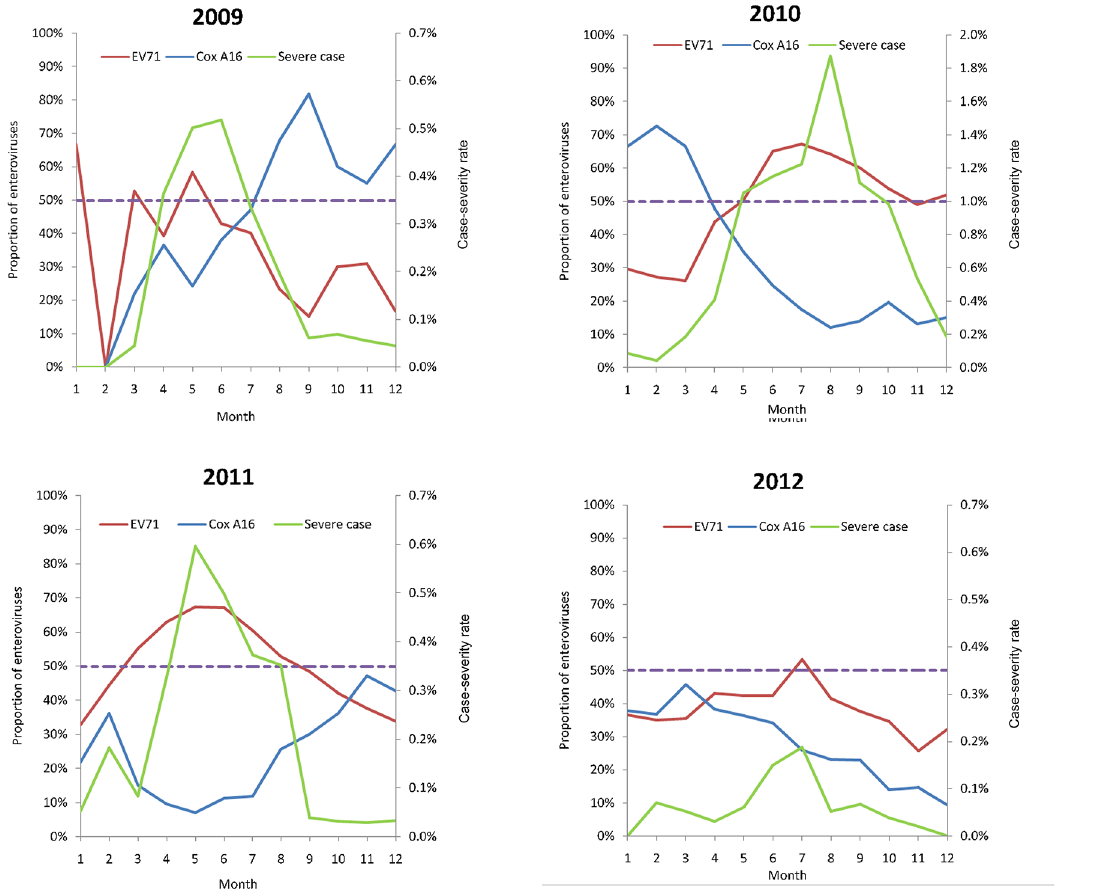
Fig 4. The partial correlations between the monthly proportions of EV71/Cox A16 and the case-severity